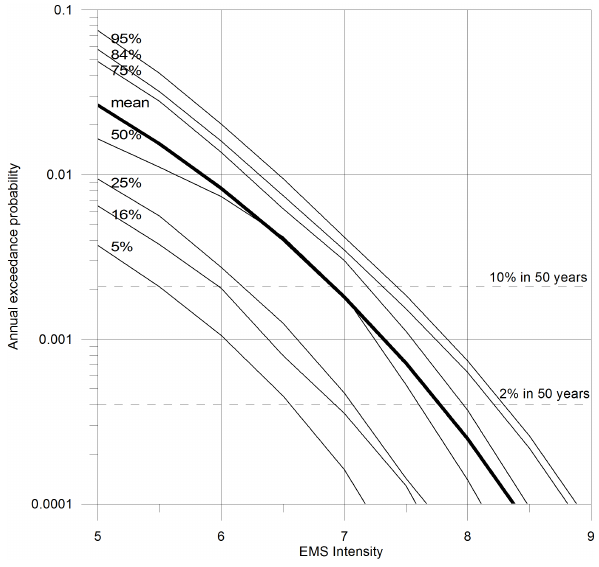
Figure 3. Calculated mean and quantile hazard curves, considering the whole range of the input parameters of the hazard part of the logic tree (Fig. 1).